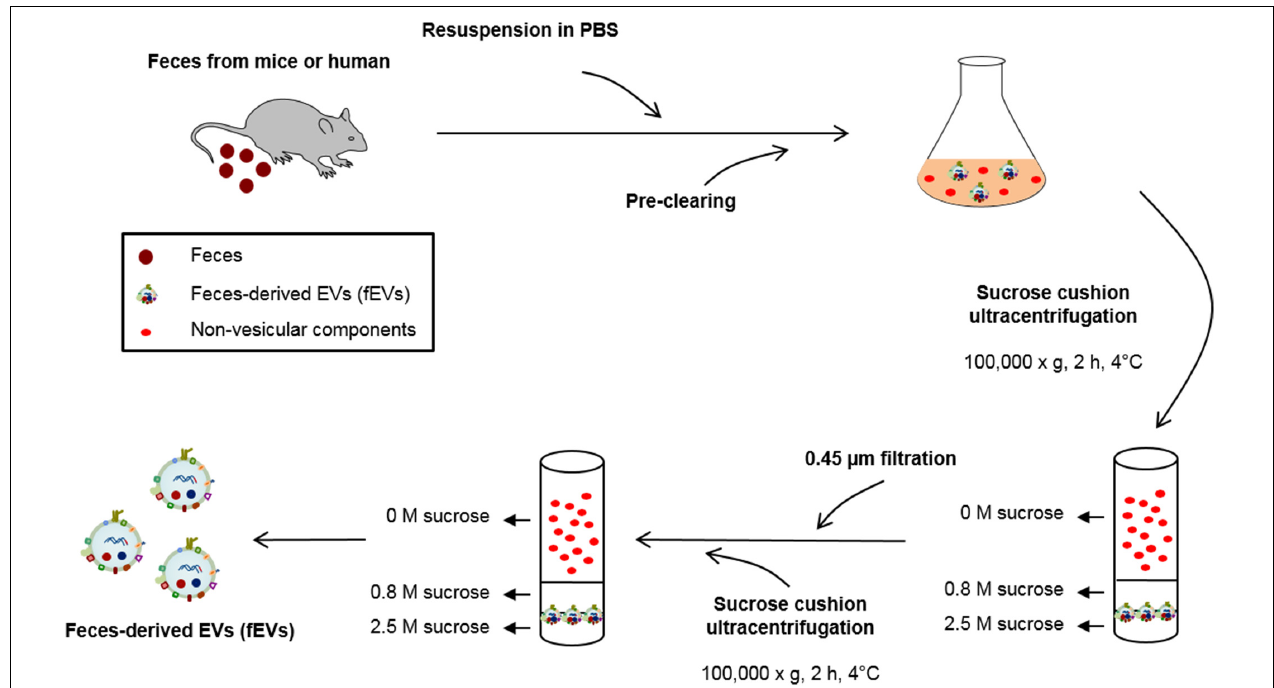
FIGURE 1 | Schematic illustration of the purification methods of fecal extracellular vesicles (fEVs). The fEVs were isolated from feces of mice and humans as illustrated. PBS, phosphate-buffered